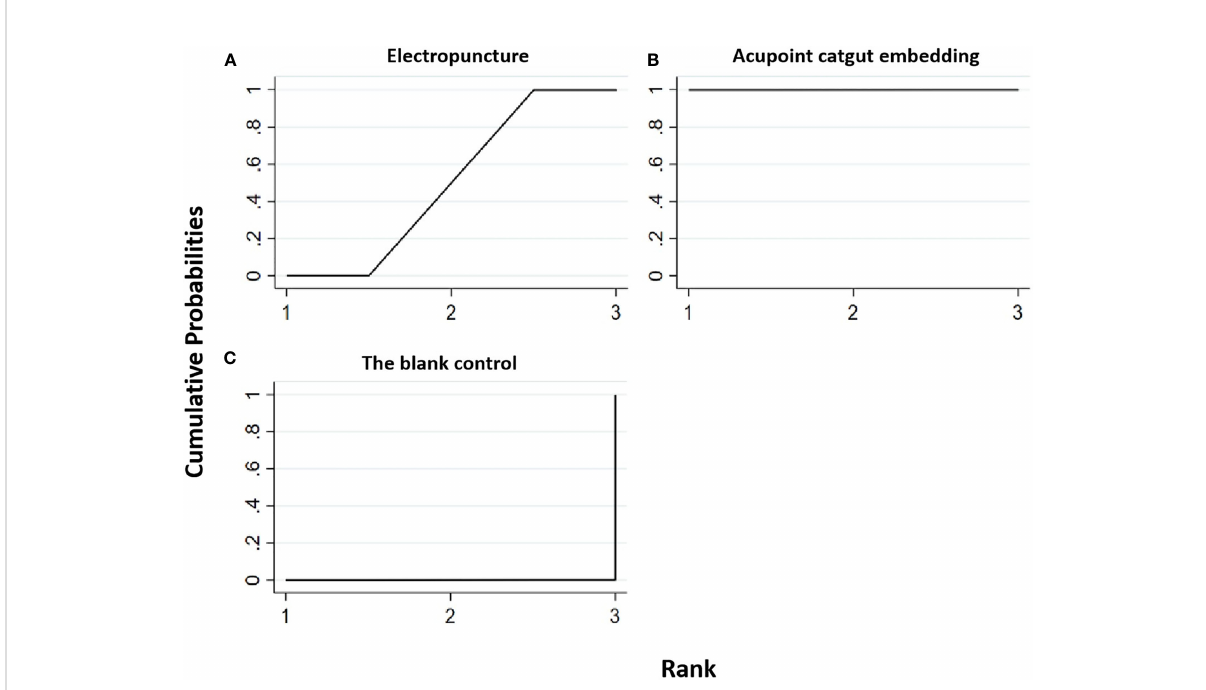
FIGURE 8 Ef fi cacy ranking and cumulative probability graph of waist – hip ratio treated by different types of intervention. Comparison of ef fi cacy ranking and cumulative probability of waist – hip ratio between each kind of intervention. (A) Electropuncture, (B) acupoint catgut embedding, and (C) blank control.